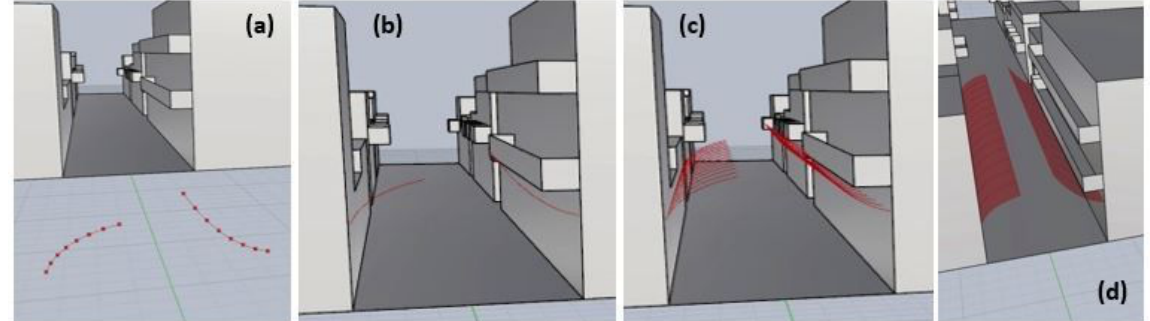
Figure 4: Process to build the geometry of the noise screens. (a) definition of the shape; (b) starting point; (c)-(d) extrusion along the facade